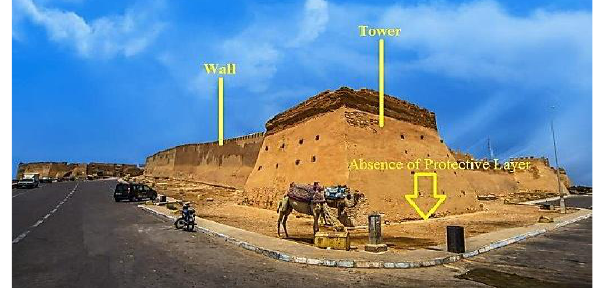
Figure 8. Absence of the Protective layer in the kasbah walls and